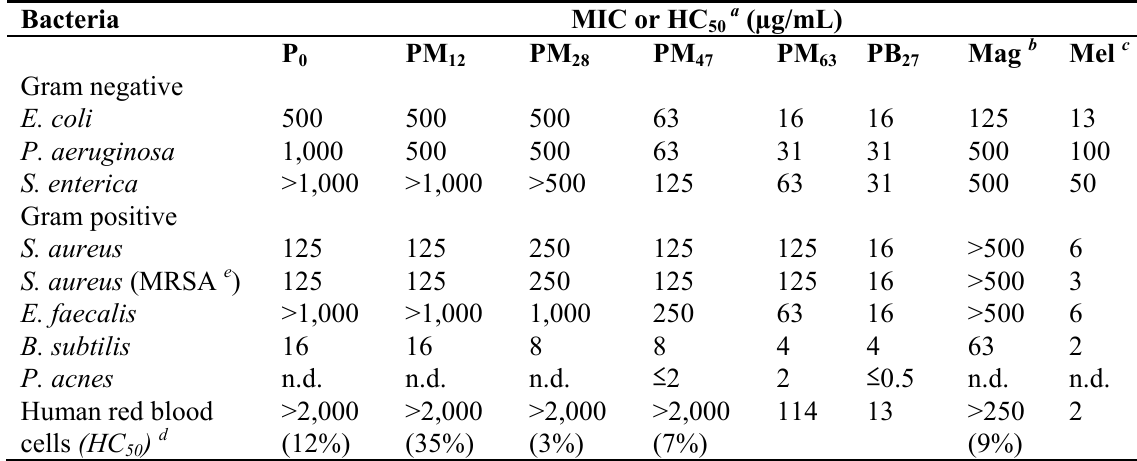
Table 2. Activity spectra of PMAs and control